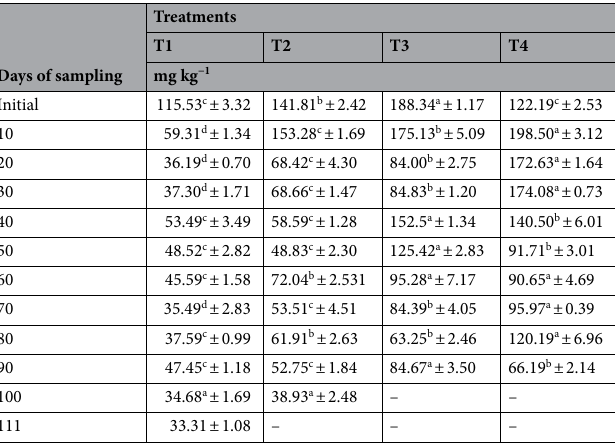
Table 11. Chicken litter biochar on total phosphorus at one hundred and eleven days after transplanting MR219. Different letters within a row indicates significant difference between means of four replicates ± standard error using Tukey’s test at p ≤ 0.05.